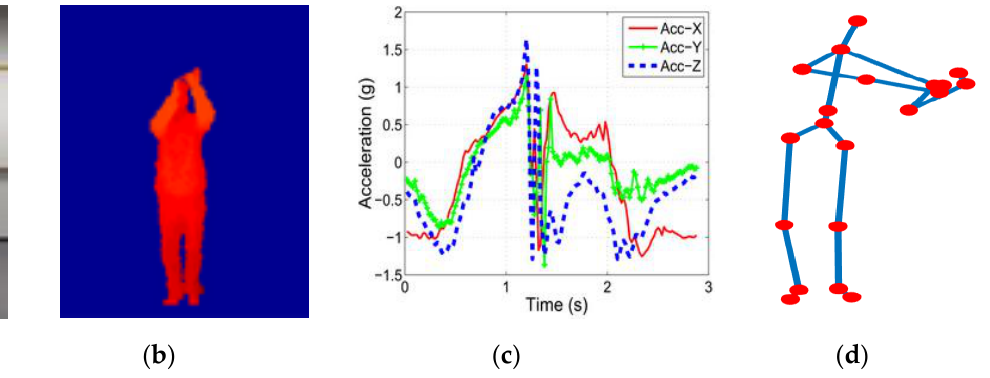
Figure 1. Different modalities of datasets: ( a ) RGB, ( b ) depth, ( c ) inertial, and ( d ) skeleton datasets.